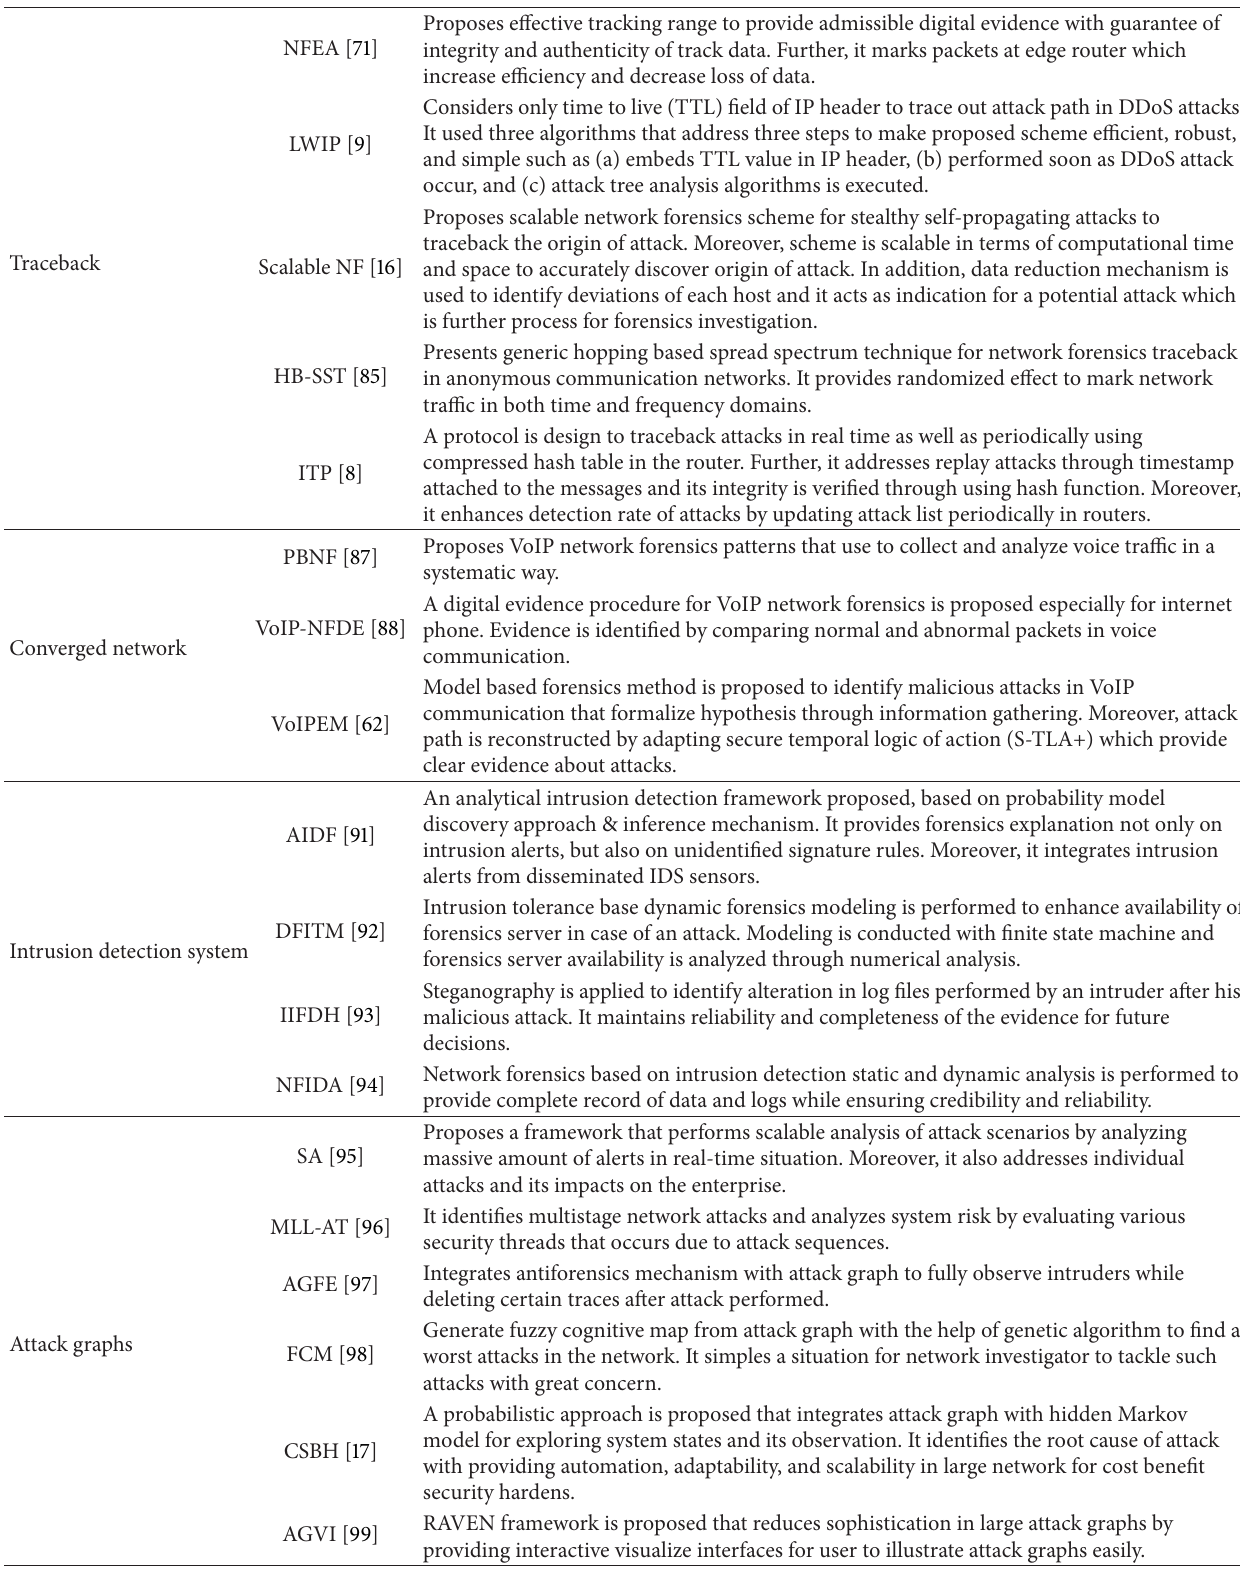
Table 4: Classification of network forensics